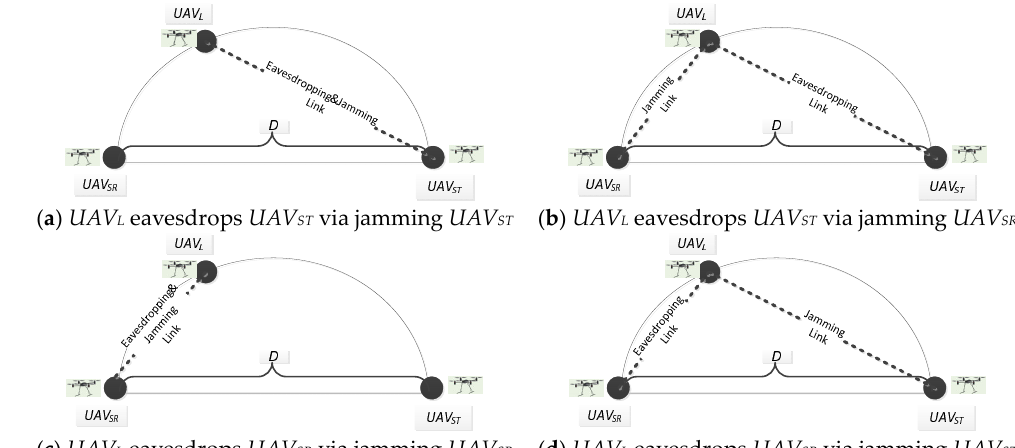
Figure 2. Eavesdropping via jamming.